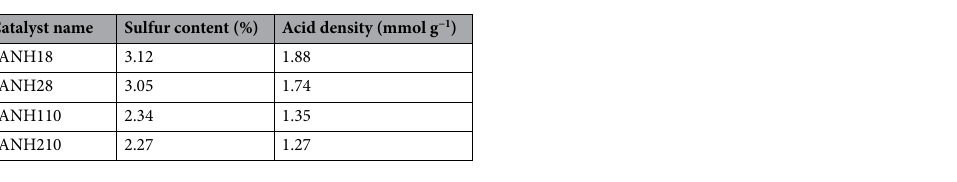
Table 1. Sulfur content and acid density of synthesized catalyst.